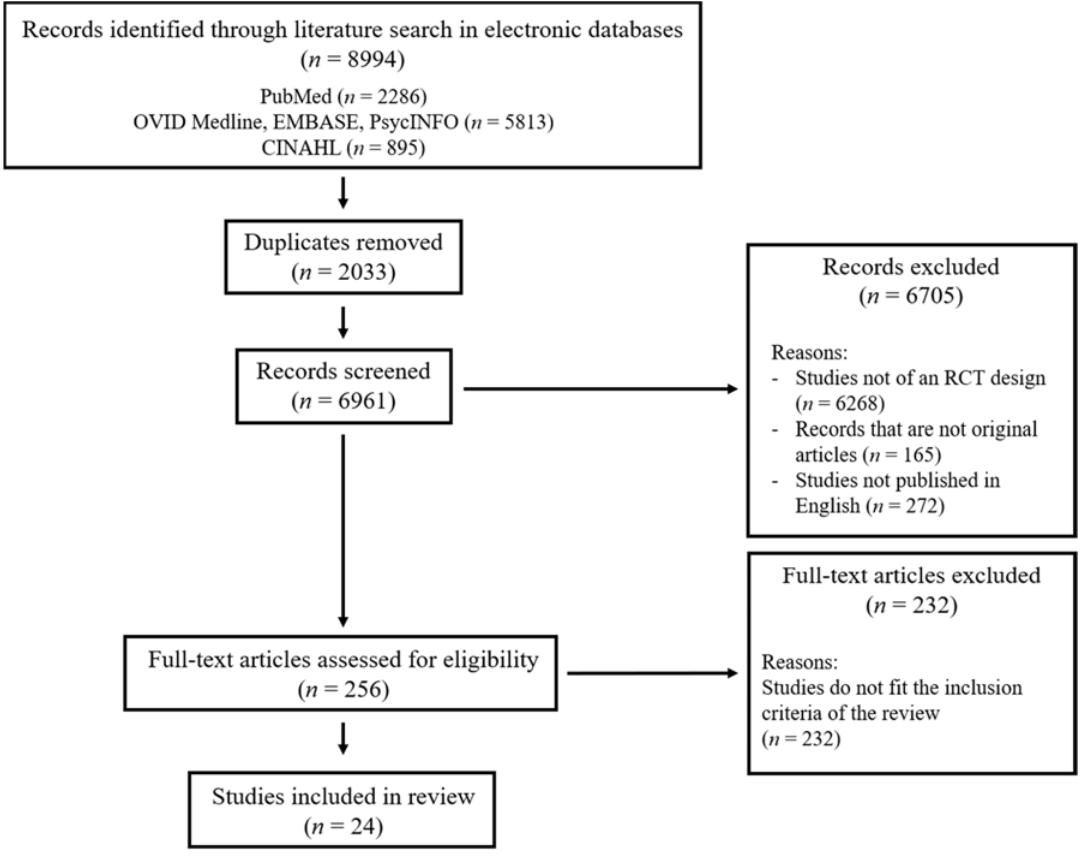
Figure 1. The PRISMA Diagram.